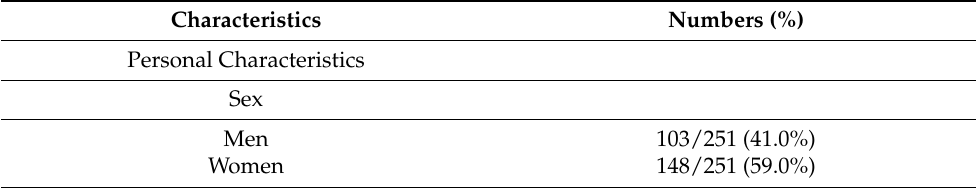
Table 1. Characteristics of the sample of Belgian GPs who answered the surveys between January to March 2020 ( n =